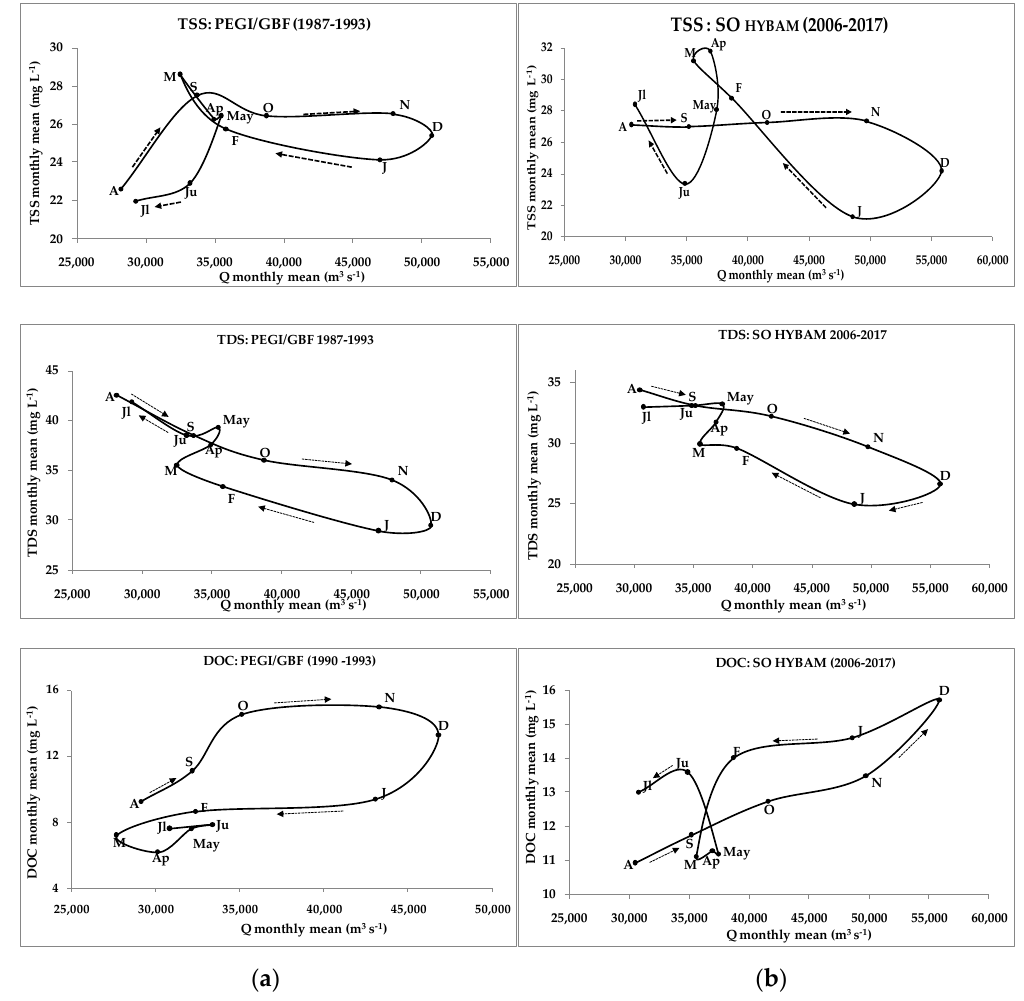
Figure 8. Hysteresis curves between monthly mean TSS, TDS and DOC concentrations versus